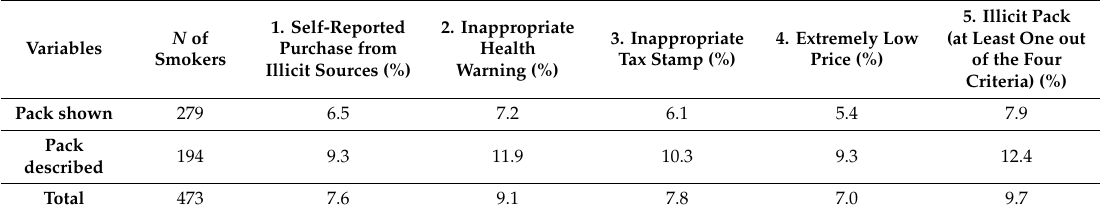
Table 6. Proportion of smokers who showed or reported illicit cigarette packs according to the selected criteria.